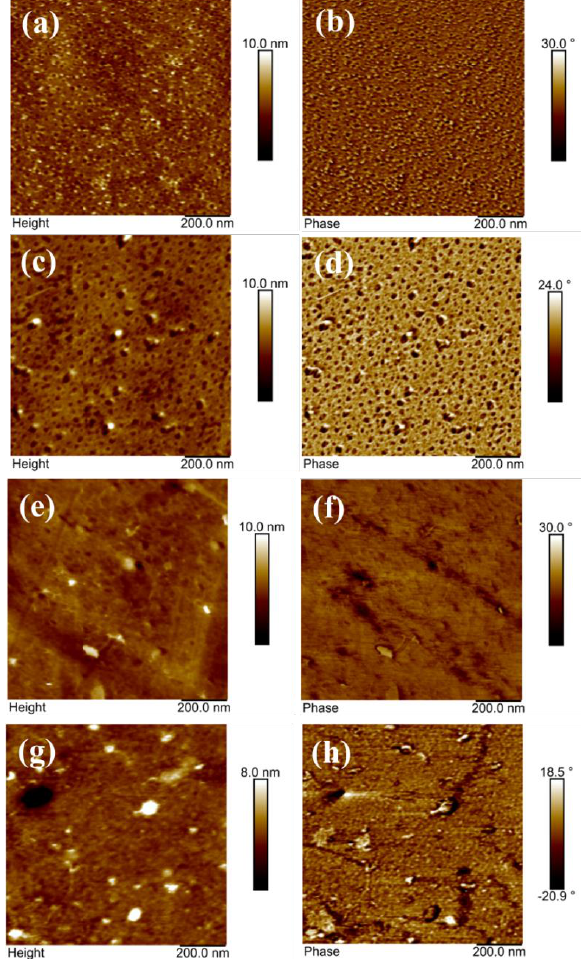
Figure 4. FE-SEM images and EDX spectra of membranes of ( a , b ) X; ( c , d ) triblock (XYX); ( e , f ) blend (2X1Y).